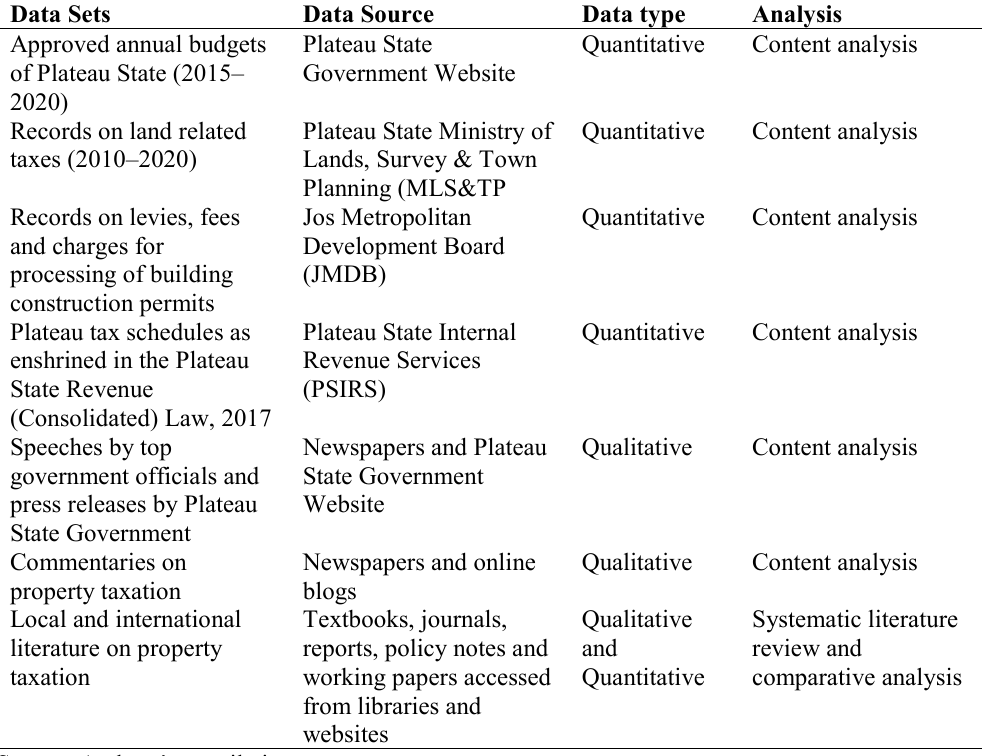
Table 1. Nature and Sources of Data and Analytical